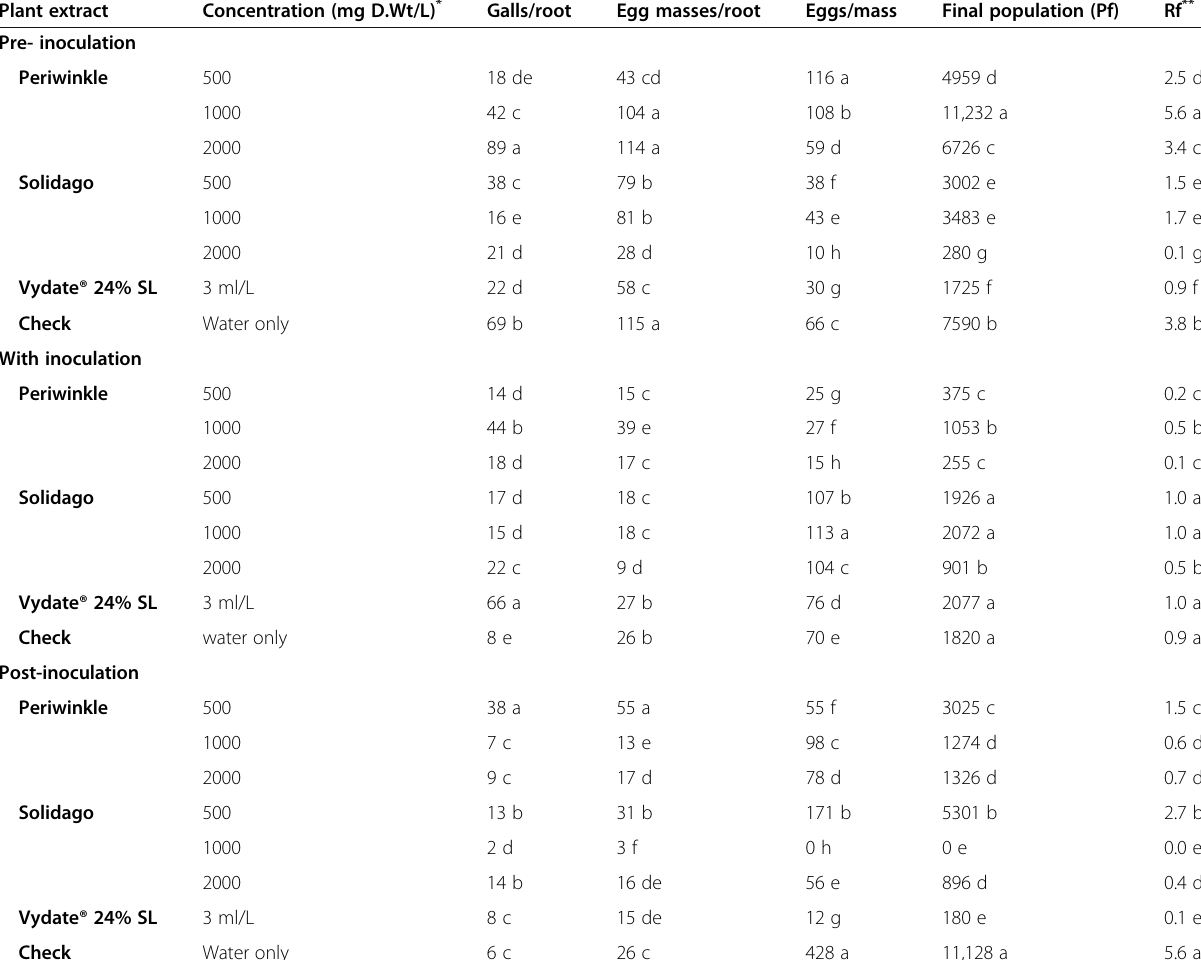
Table 5 Effect of foliar spray of periwinkle and solidago aqueous extracts at different concentrations and application time on M. incognita infecting sunflower plants Plant